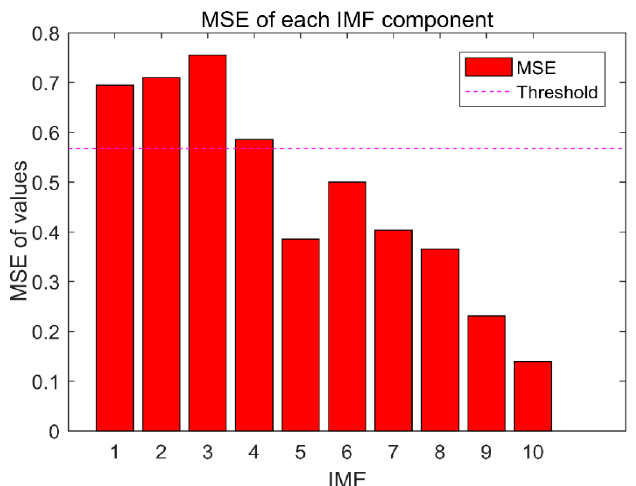
Figure 8. MSE of each IMF component.